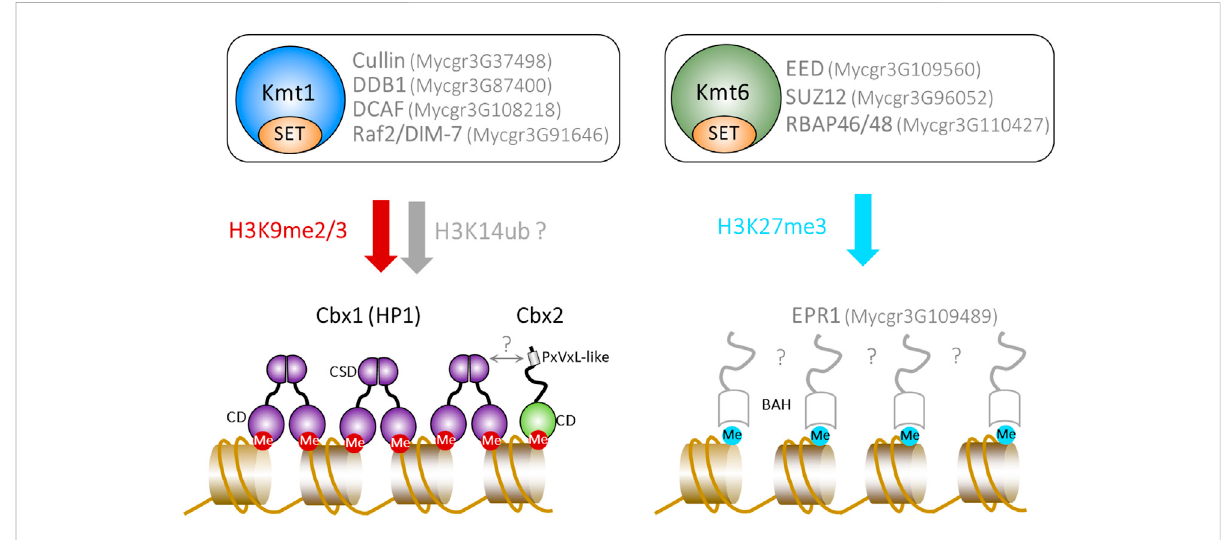
FIGURE 1 The deposition and recognition of heterochromatic histone PTMs in Z. tritici. The top panel shows the predicted composition of Kmt1 (histone H3K9) and Kmt6 (histone H3K27) KMTase complexes. The bottom panel summarises proteins known to be, or predicted to be, involved in the recognition of H3K9me2/3 and H3K27me3. Predicted proteins, activities and interactions are shown in grey. The Ensembl Fungi ID of genes encoding putative proteins is